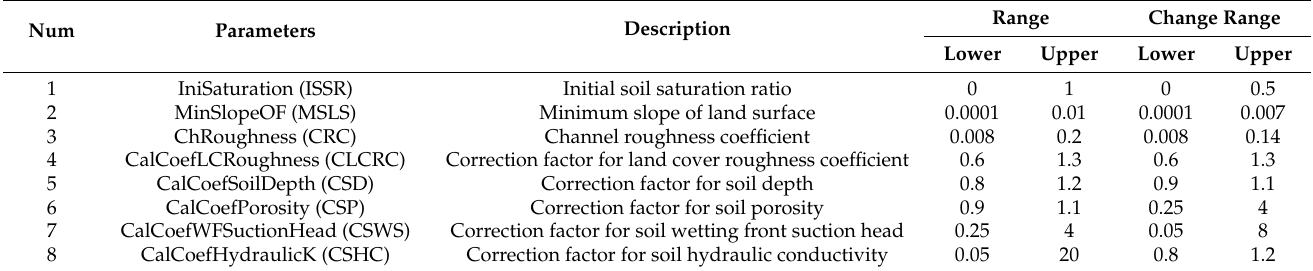
Table 3. GRM Parameters Description and Range.